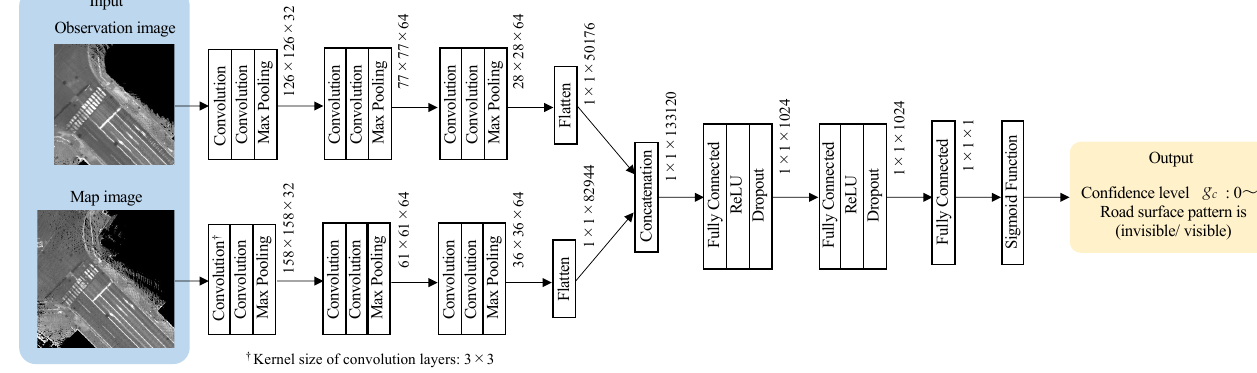
Figure 9. The learning structure for confidence